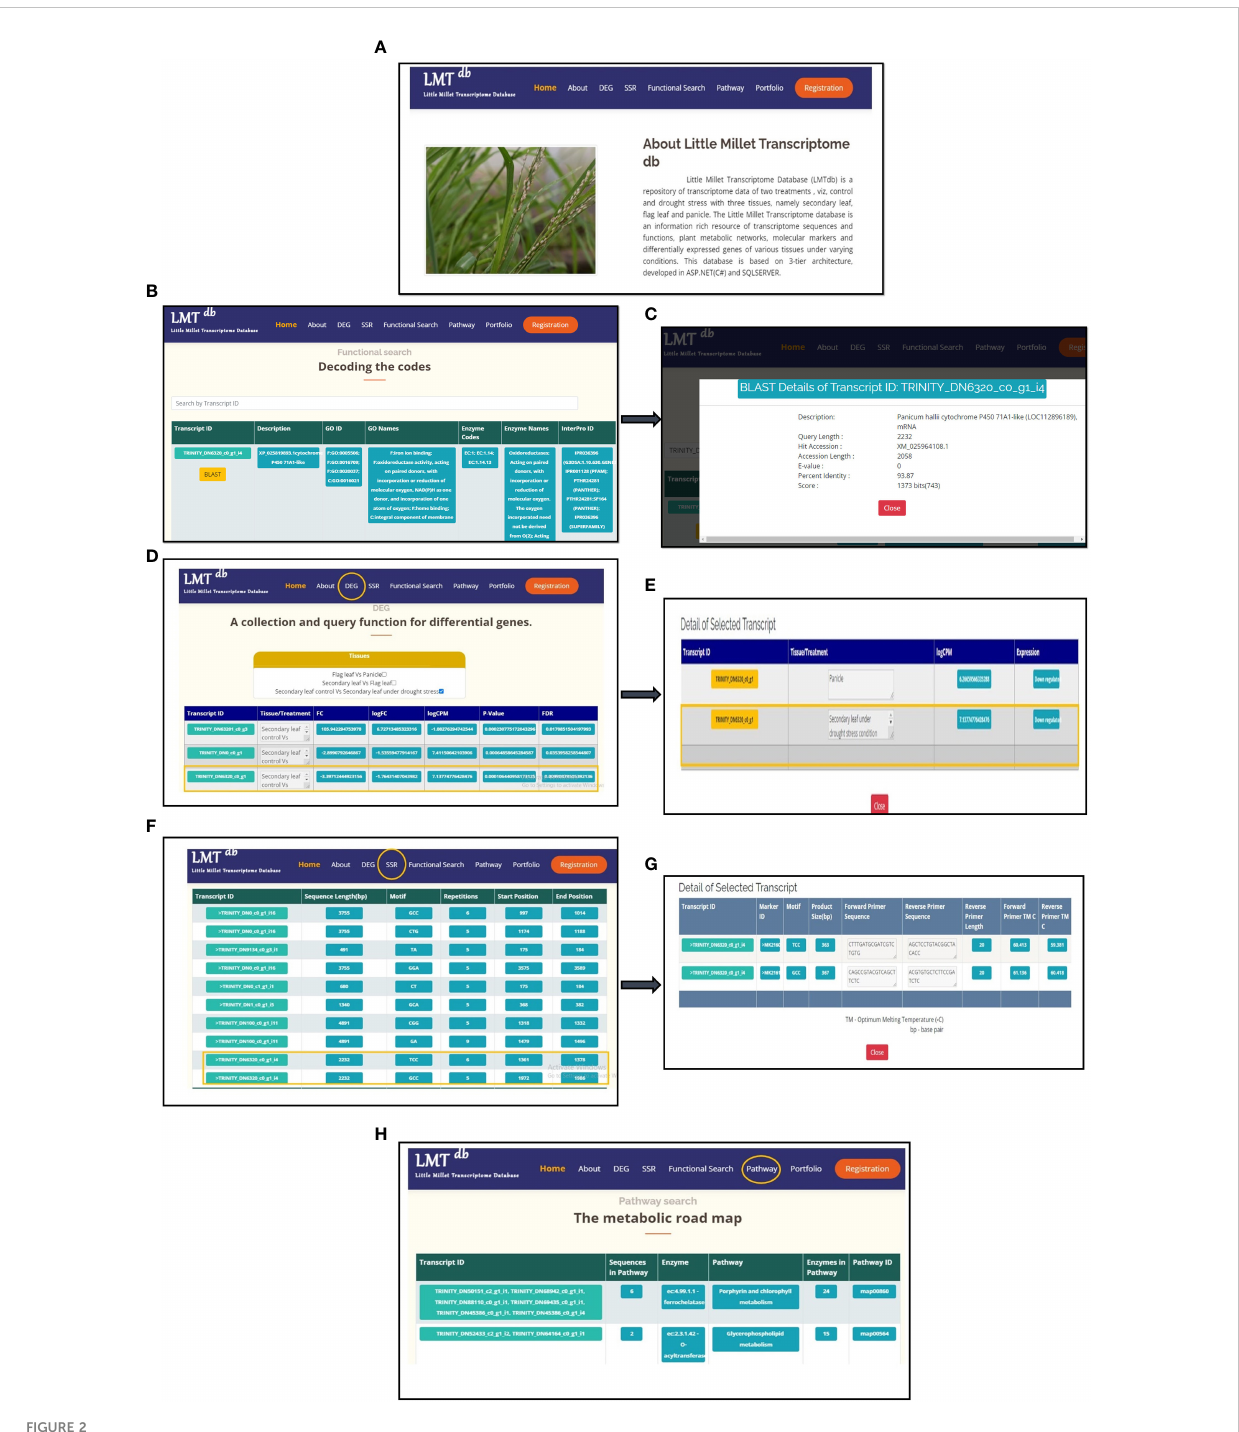
FIGURE 2 Schematic representation and screenshots of Little Millet transcriptome database (LMT db v.1.0.0). (A) Representation of key elements (DEGs, SSRs, Functional Search, Pathway, and Portfolio) of the database as displayed on the database homepage. (B) Functional Search page displaying information related to CYP71A1 like gene (TRINITY_DN6320_c0_g1_i4). (C) BLAST details for CYP71A1 like gene (TRINITY_DN6320_c0_g1_i4) (D) Comparative search for CYP71A1 like gene under DEG module. (E) Downregulation of CYP71A1 like gene in secondary under drought stress. (F) Representation of SSRs information for CYP71A1 like gene. (G) Primer details corresponding to CYP71A1 like gene. (H) Metabolic pathway information with enzymes and pathway IDs corresponding to different